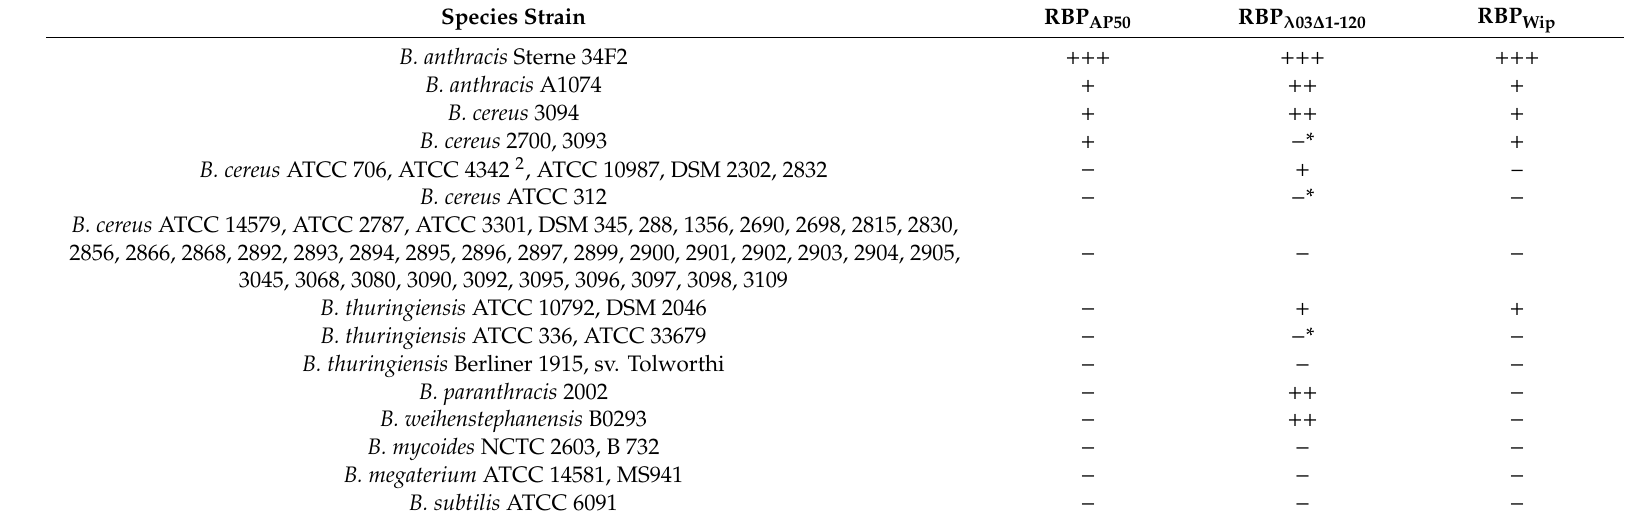
Table 3. Labeling of Bacillus spp. cells with RBP reporters 1